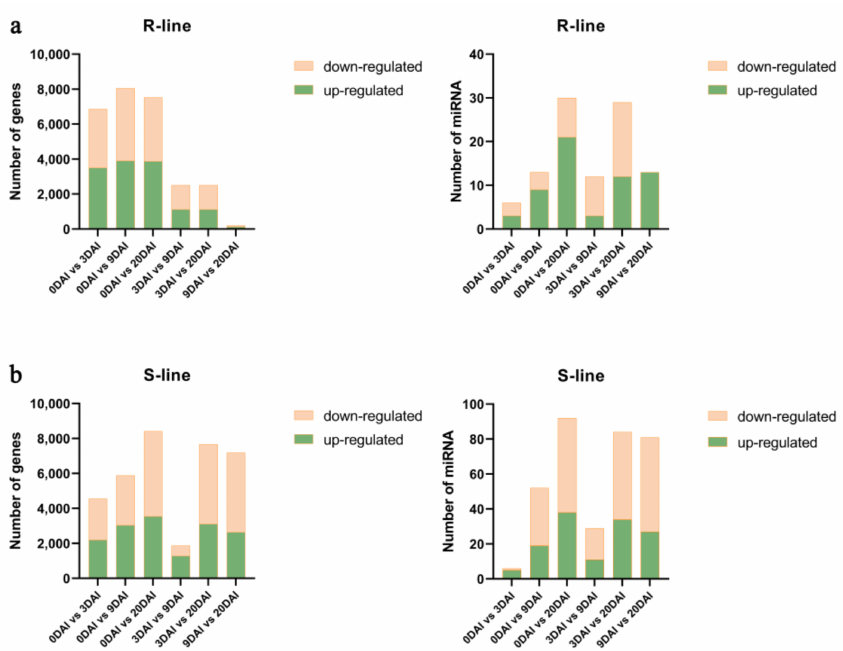
Figure 3. ( a ) Number of up- and down-regulated DEmiRNAs and DEGs in the R-line material BrT24 and ( b ) number of up- and down-regulated DEmiRNAs and DEGs in the S-line Y510-9 in different development